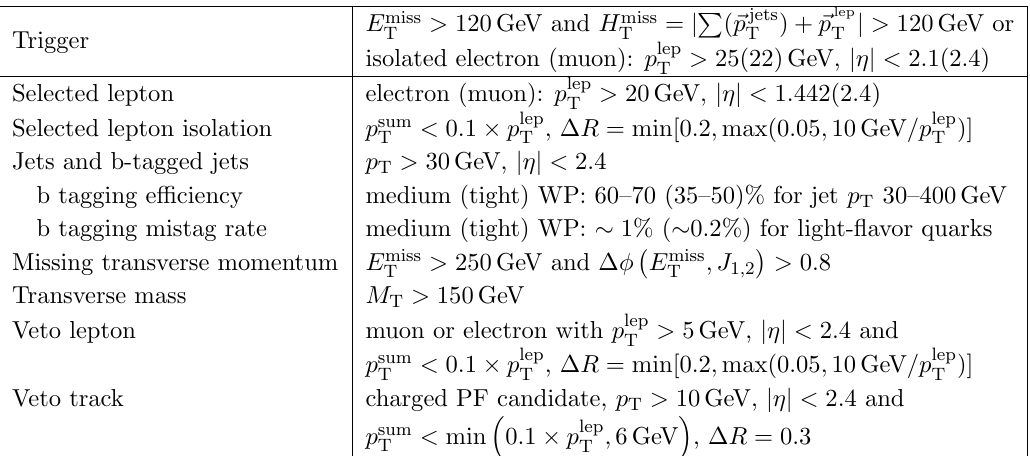
Table 1 . Summary of the event preselection. The symbol p lep p sum is the scalar p T sum of PF candidates in a cone around the lepton but excluding the lepton. T For veto tracks this variable is calculated using charged PF candidates, while in the case of selected and veto leptons neutral PF candidates are also included. The veto lepton and track de(cid:12)nitions are used for event rejection as described in the text. Light-(cid:13)avor jets are de(cid:12)ned as jets originating from u, d, s quarks or